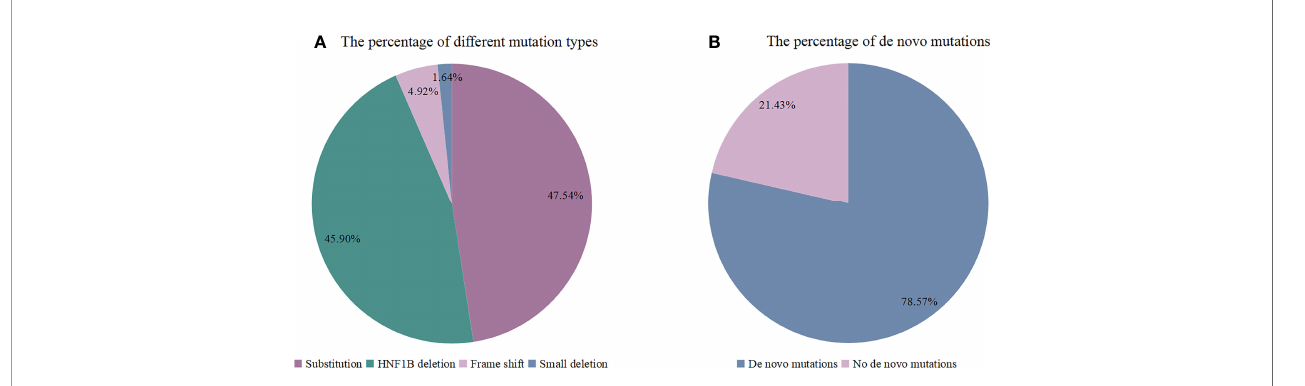
FIGURE 4 | (A) The percentage of different mutation types (N: 61), (B) The percentage of de novo mutations